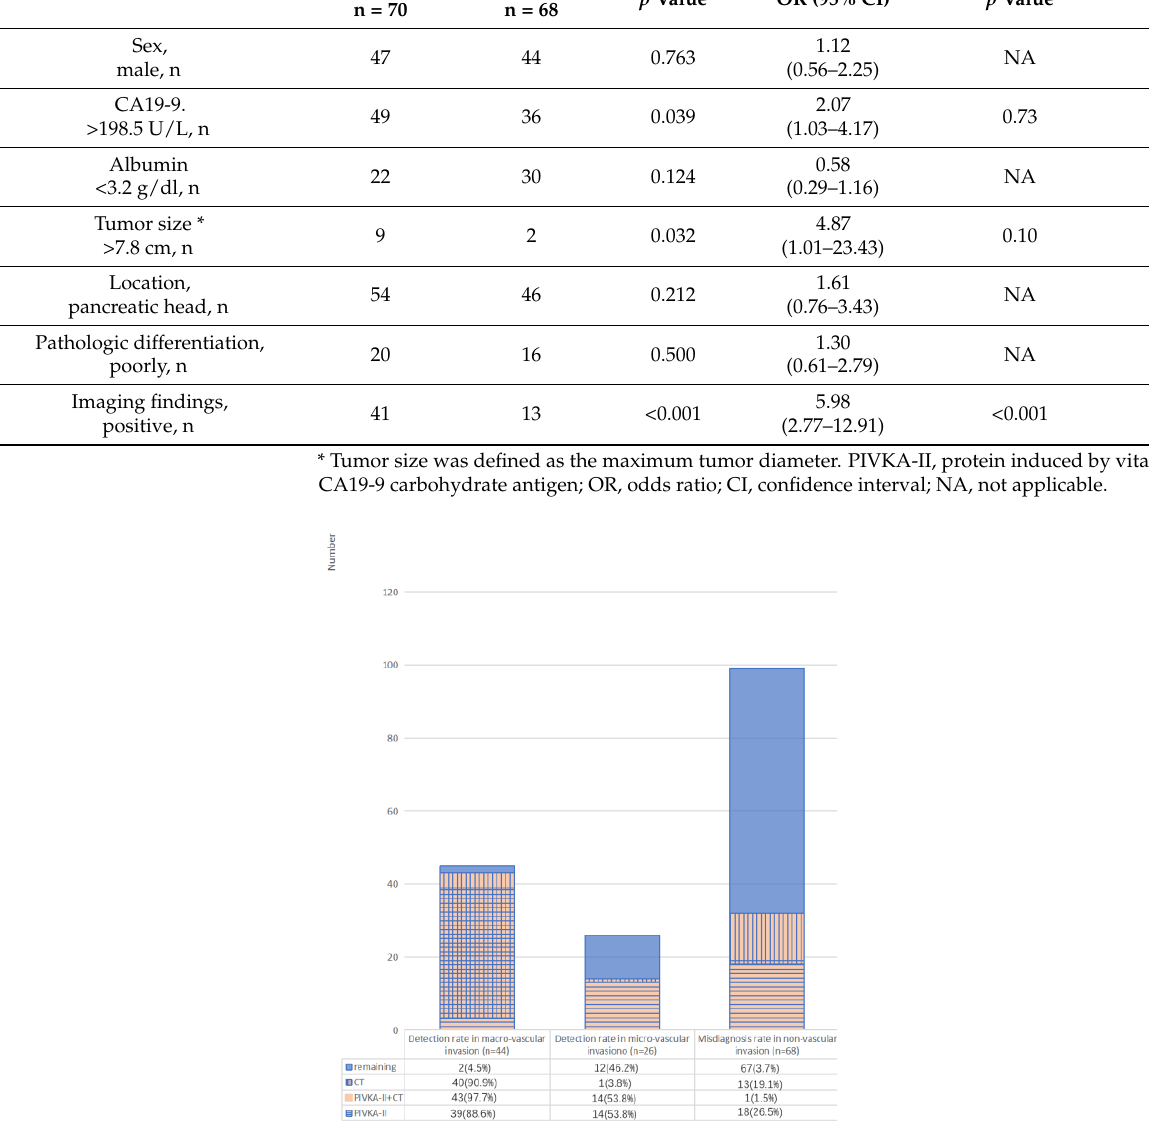
Figure 6. Diagnostic efficacy of PIVKA-II, CT examination and their combination for vascular inva- sion in PDAC. When we evaluate the diagnostic efficacy of combined CT examination and PIVKA- II for vascular invasion in PDAC, single positive was defined as positive and double negative was defined as negative. PIVKA-II, Protein induced by vitamin K absence-II; CT, computed tomography; PDAC, pancreatic ductal